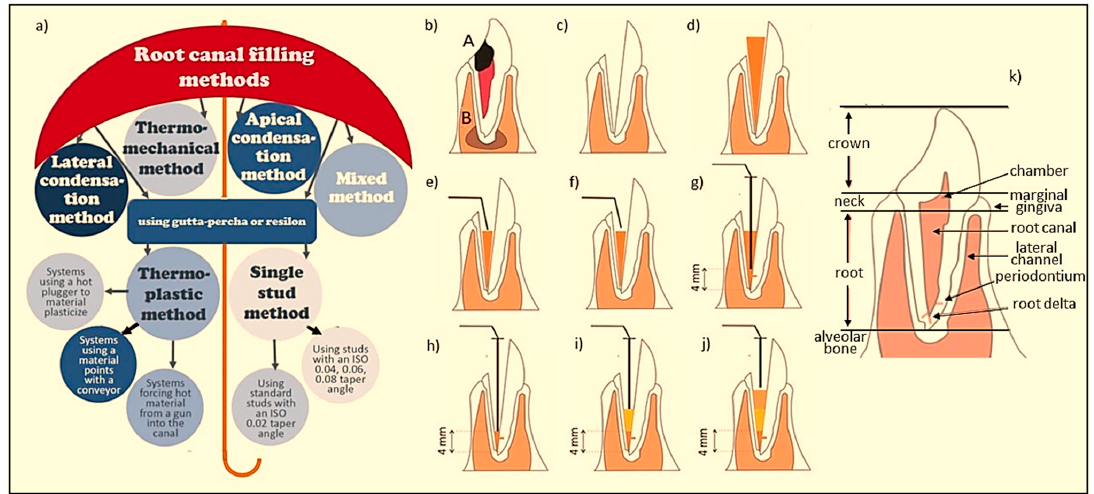
Figure 9. Scheme of root canal obturation methods in endodontics: ( a ) classification of methods in the form of an umbrella; ( b ) dead pulp due to a carious lesion (A) with a periapical lesion (B); ( c ) evacuation of the ventricular root pulp and conical root canal preparation; ( d ) fitting the main cone to the root canal; ( e ) cutting off the main stud with a heated plugger; ( f ) condensation at the mouth of the severed main cone with a cold Buchanan plugger; ( g ) plasticizing the main stud by introducing the heated plugger to a depth 4 mm less than the working length and cutting off the excess stud; ( h ) condensation of the plasticized main cone with a cold Buchanan plugger; ( i ) filling 1/3 of the central part of the channel with liquid filling material plasticized outside the channel and then condensing the material with a cold Buchanan plugger as in ( h ); ( j ) final filling of the channel with liquid filling material plasticized outside the channel and then condensation of the material with a cold Buchanan plugger as in point ( h ); ( k ) the functions of the tooth pulp before the onset of caries symptoms.